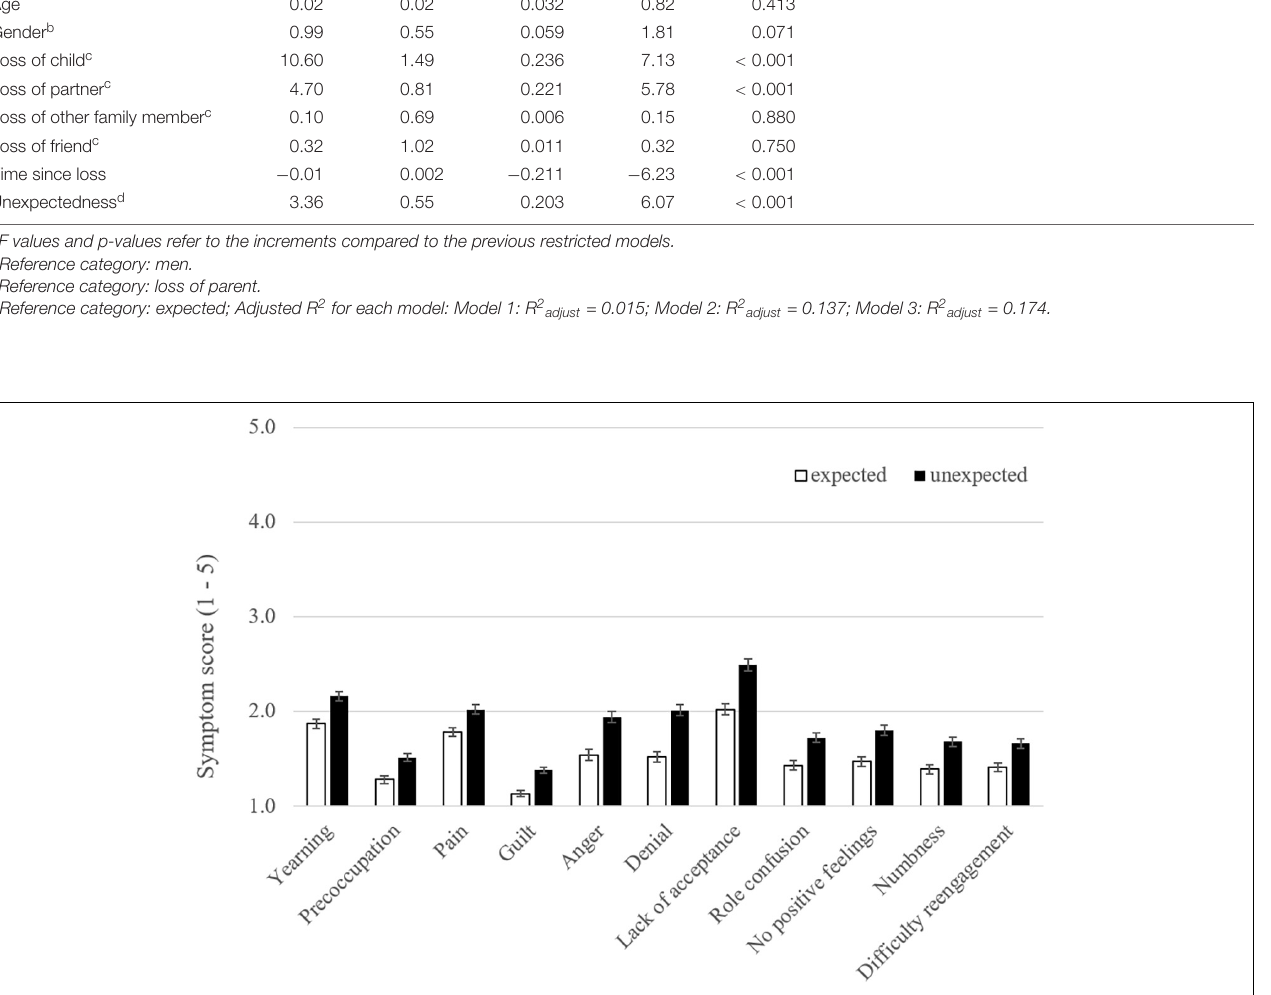
Frontiers in Psychiatry |